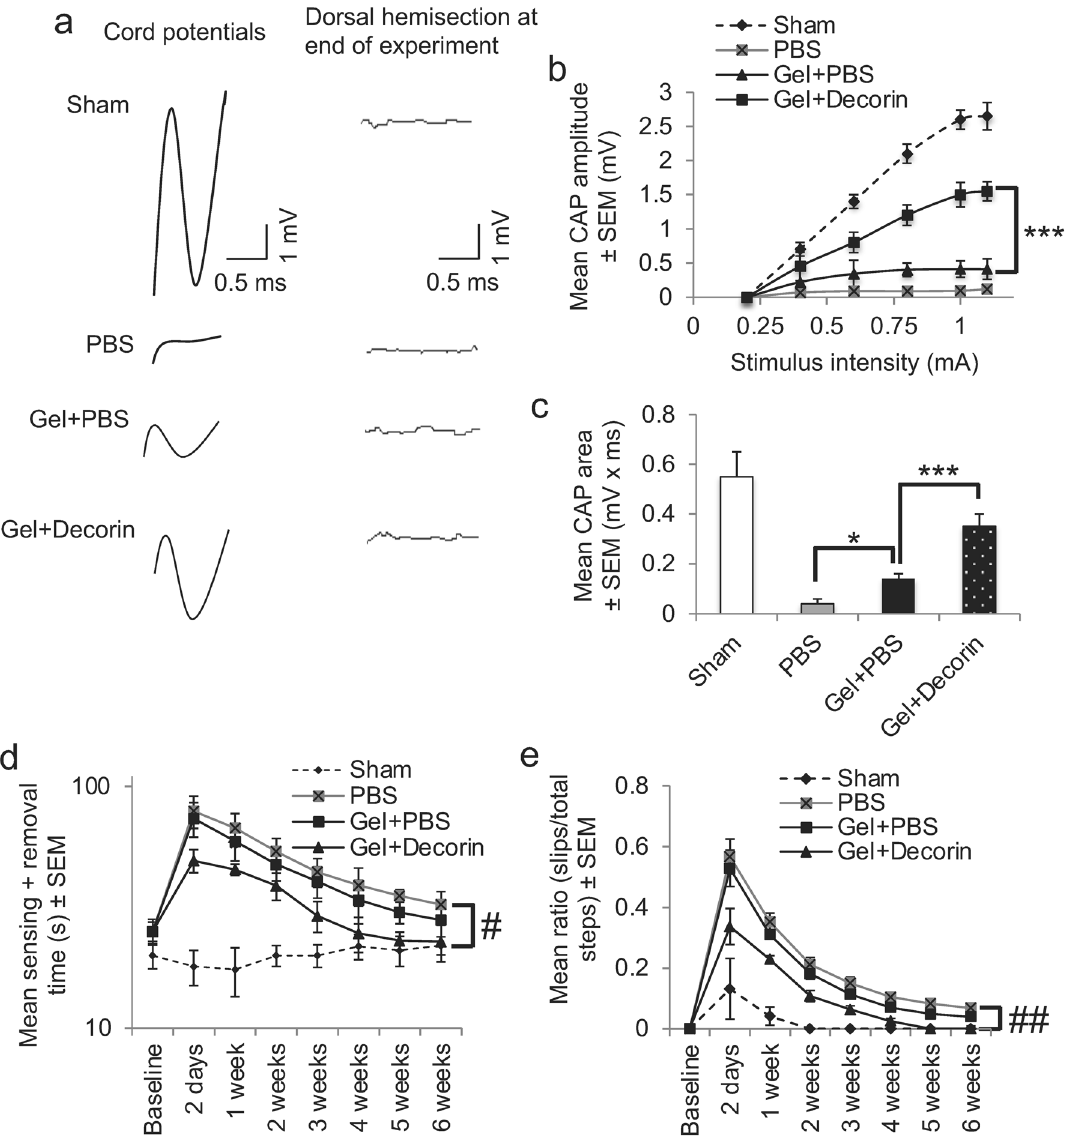
Figure 8. Gel + Decorin injections improved electrophysiological and functional recovery after DC injury. ( a ) Spike 2 processed CAP traces from representative Sham controls, PBS, Gel + PBS and Gel + Decorin-treated rats showing significant recovery of dorsum cord potentials in Gel + Decorin treated rats. There is also a slight improvement in Gel + PBS-treated animals. Dorsal hemisection between the stimulating and the recording electrodes at the end of the experiment ablated CAP traces in all animals demonstrating technical success of the experiment. ( b ) CAP amplitudes (mV) were attenuated in the Gel + PBS treated group but were significantly improved in Gel + Decorin injected rats. ( c ) Mean CAP area was significantly improved in Gel + Decorin versus Gel + PBS-treated rats. ( d ) Mean sensing time for the tape sensing and removal test and mean error ratios for the ( e ) horizontal ladder walking test both show significant recovery of sensory and locomotor function, respectively, after Gel + Decorin treatment. * P < 0.05, *** P < 0.0001, one-way ANOVA with Dunnett’s post hoc test; # P < 0.0012, linear mixed model (LMM); ## P < 0.0001, generalised linear mixed model (GLMM). n = 6 rats/ group, 3 independent repeats, total n = 18